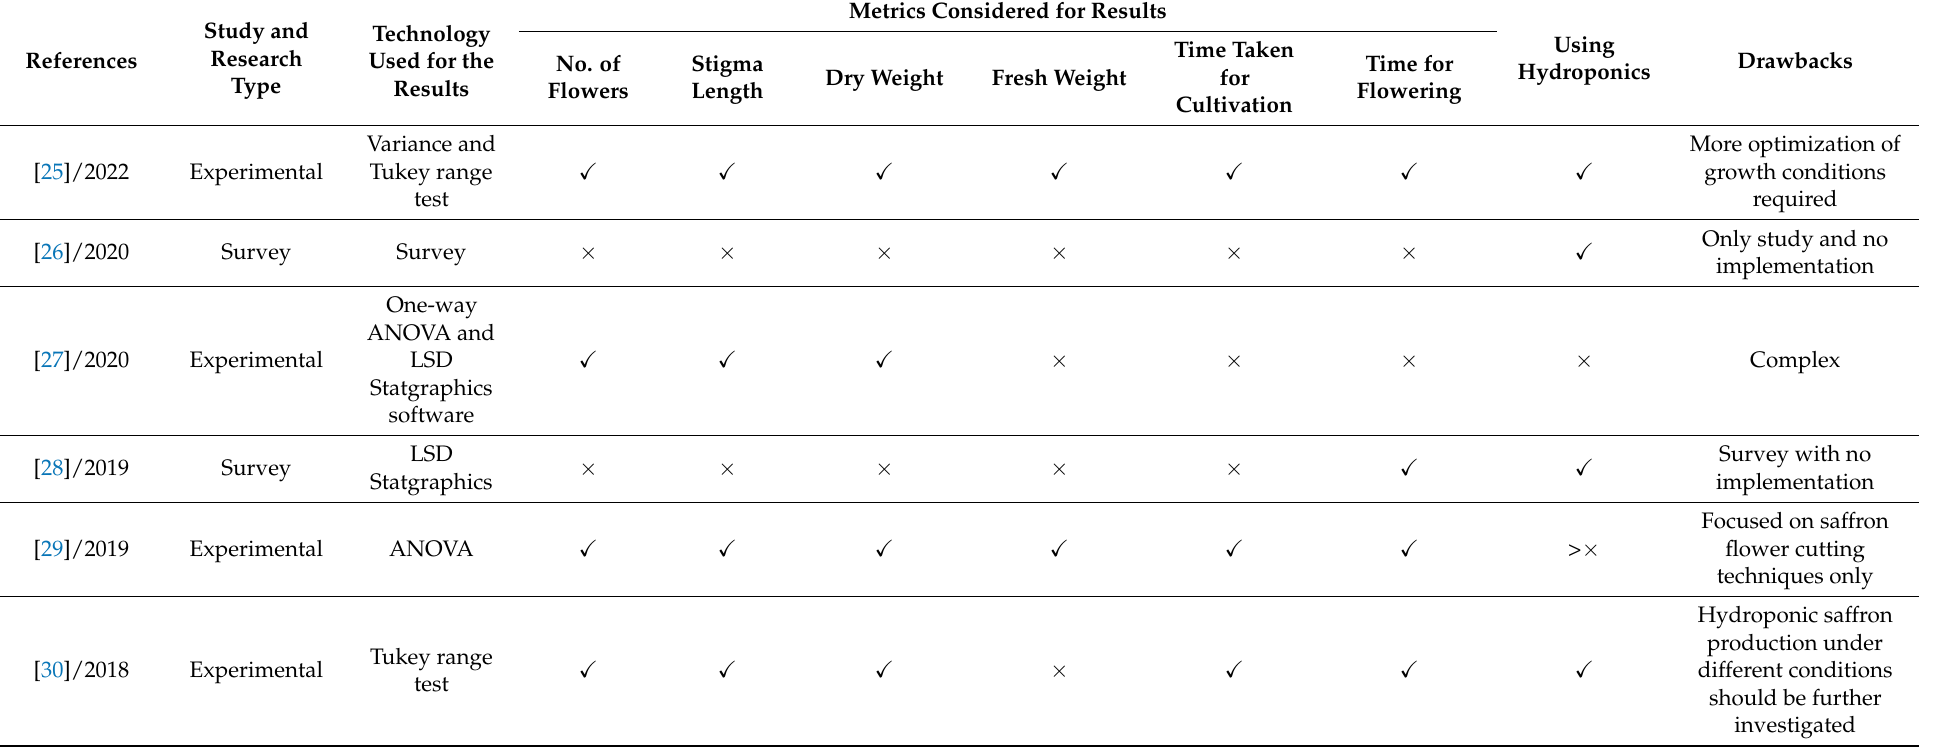
Table 2. Different artificial techniques for saffron